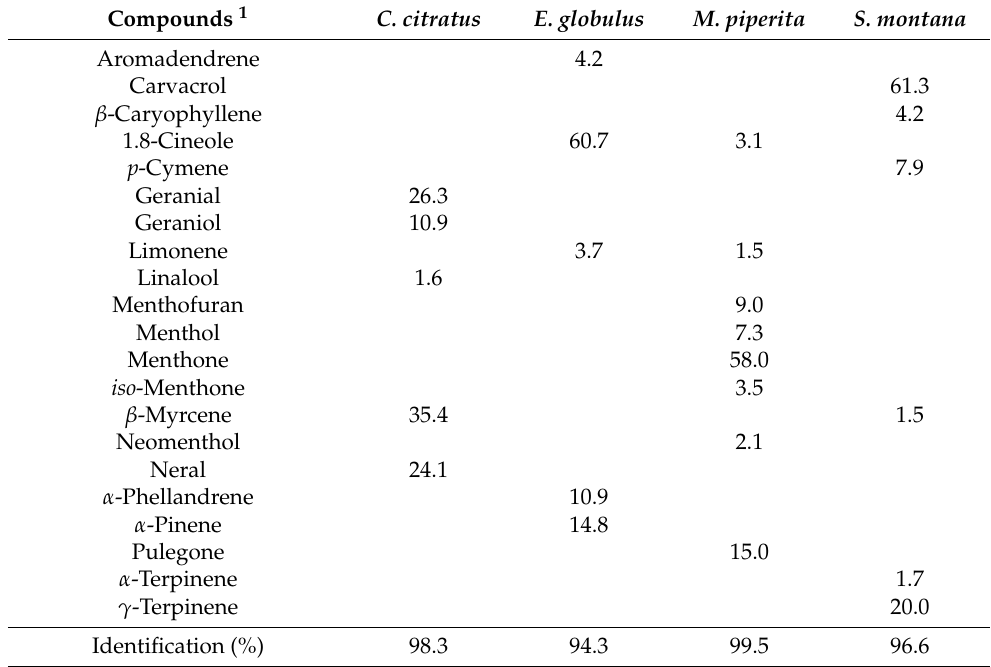
Table 1. Relative amounts (%) of volatile compounds, obtained by GC-MS, in the essential oils of Cymbopogon citratus , Eucalyptus globulus , Mentha piperita and Satureja montana